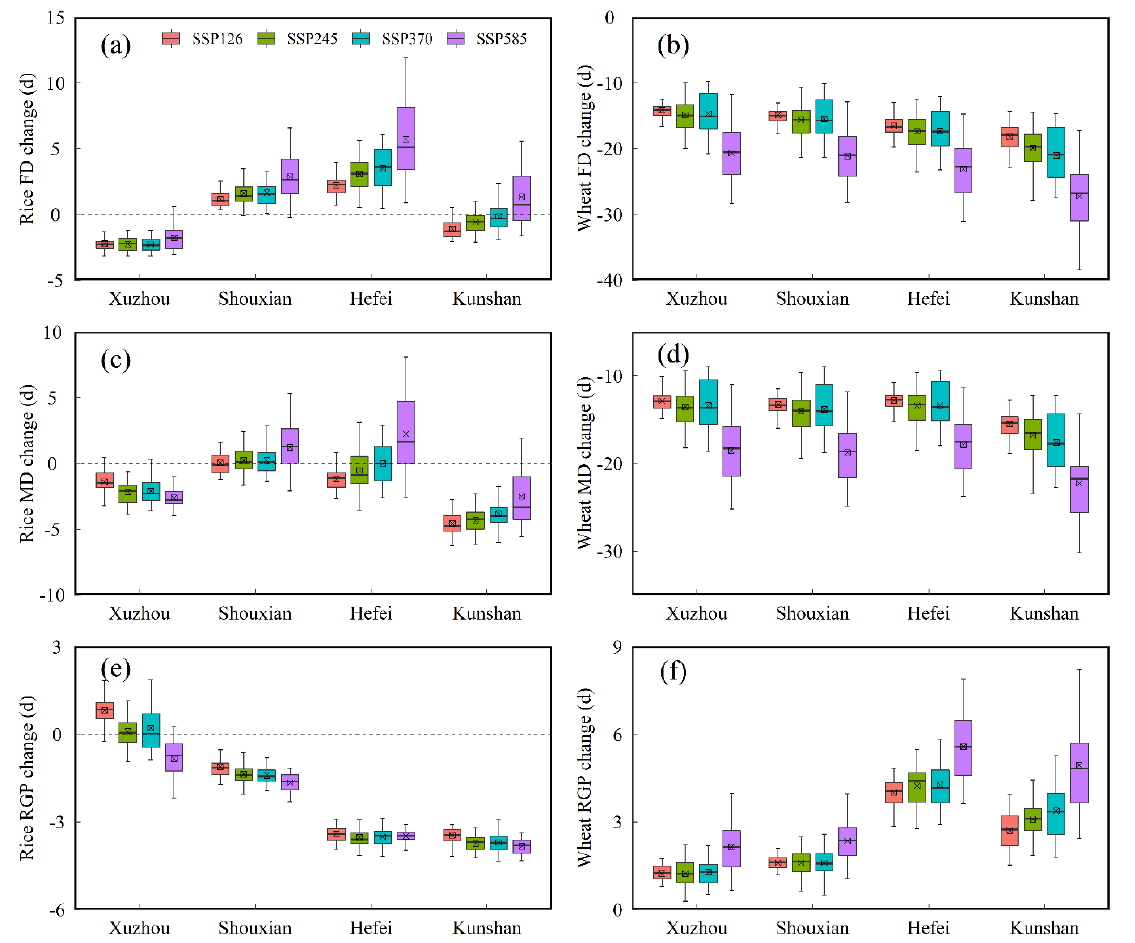
Figure 4. Projected changes in flower date (FD) ( a , b ), maturity date (MD) ( c , d ) and reproductive grow period (RGP) ( e , f ) for rice ( a , c , e ) and wheat ( b , d , f ) in the 2050s (2041 – 2070) period under SSP126, SSP245, SSP370 and SSP585 compared to the baseline period (1981 – 2010) across the 22 CMIP6 GCMs in the four agro-meteorological stations.